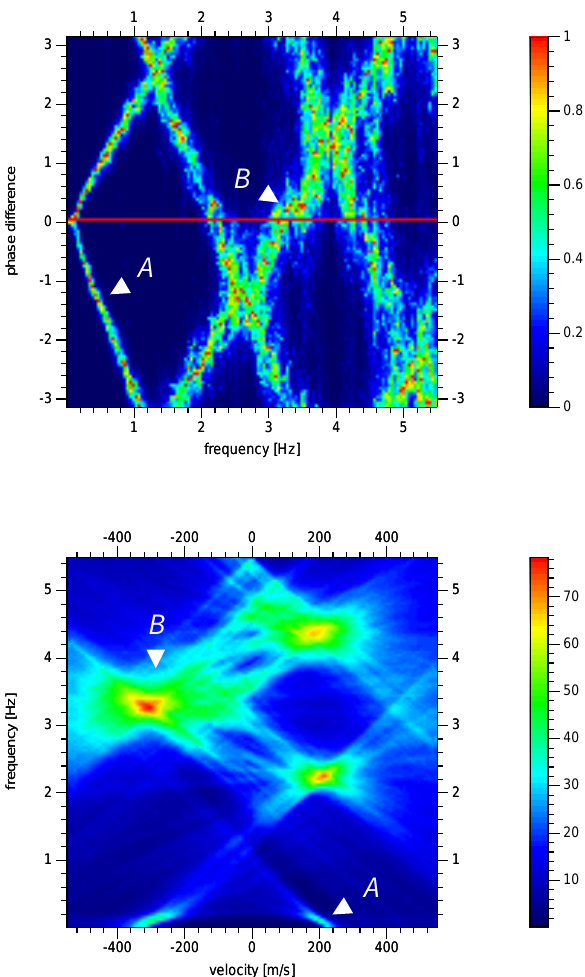
Fig. 8. Phase-frequency distribution for test signals – upper panel, and corresponding Radon trnsform – lower panel. Labeled features ilustrates corespondence between phase-frequency distribution and its Radon transform. The line 1φ = 0 is drawn in